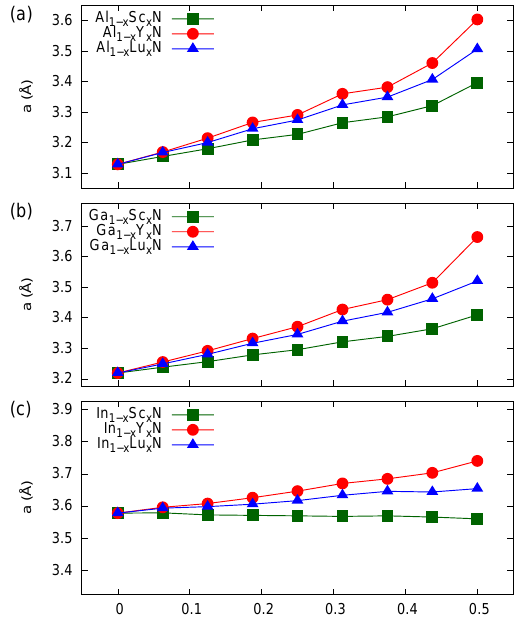
Figure 1. Lattice parameters a calculated (GGA) for wurtzite alloys ( a ) Al 1 − x RE x N, ( b ) Ga 1 − x RE x N, ( c ) In 1 − x RE x N, where RE = Sc, Y, and Lu.